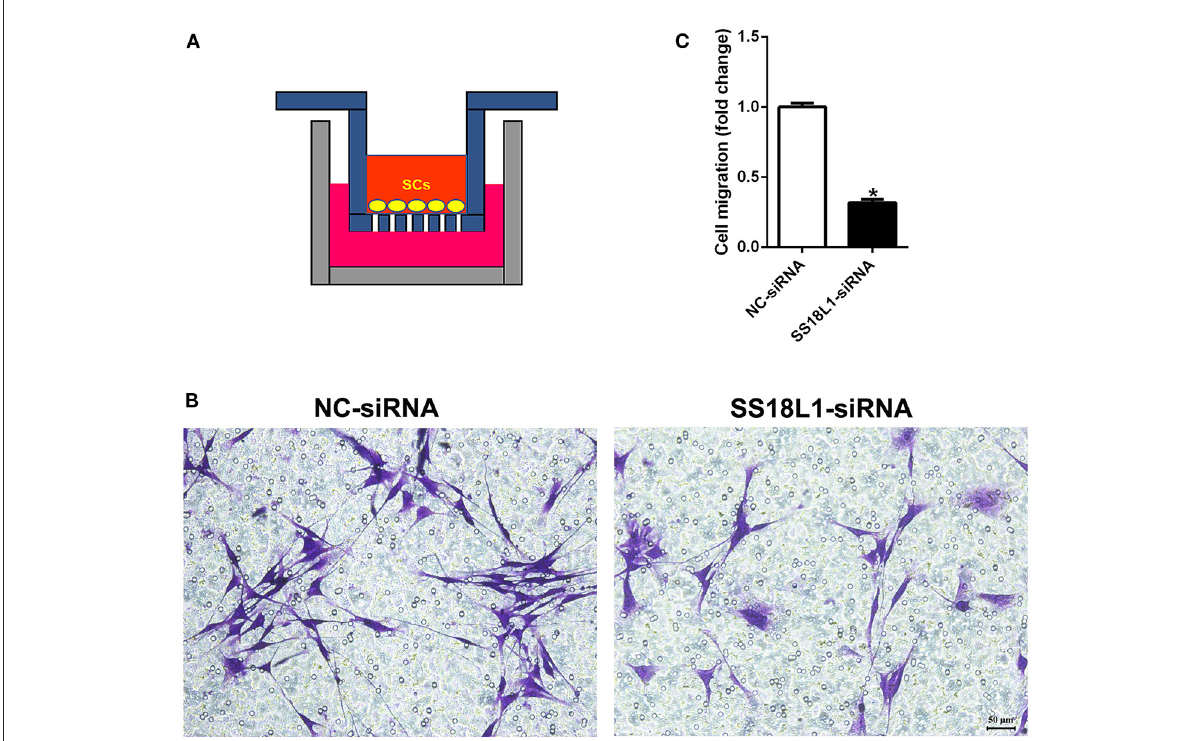
FIGURE4 The effect of SS18L1 on Schwann cell migration. (A) The schematic diagram of cell migration assay. (B) Representative images of the migration of Schwann cells transfected with SS18L1 siRNA or siRNA control. Violet color indicated Schwann cells migrated toward the bottom surface. Scale bars indicated 50 µ m. (C) Summarized histogram of the migration of Schwann cells transfected with SS18L1 siRNA or siRNA control. * P < 0.05, vs. siRNA